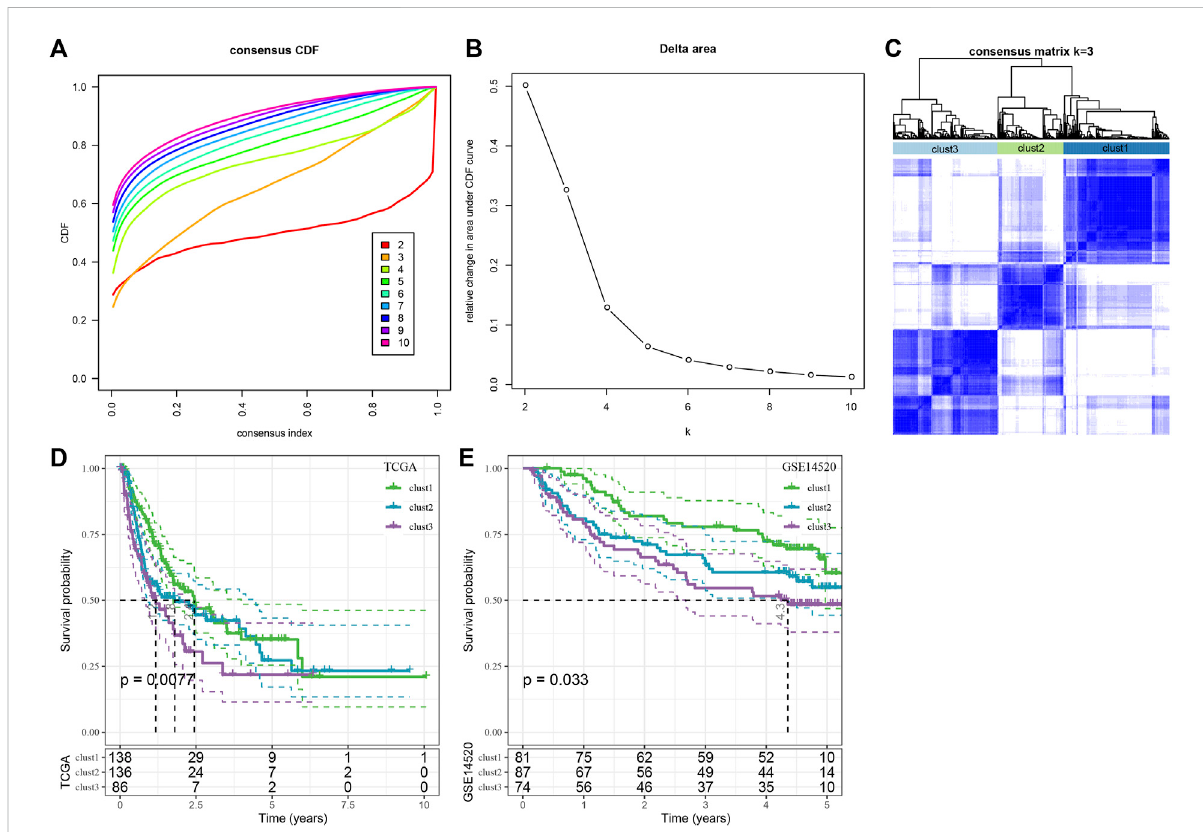
FIGURE 2 Consensus clustering analysis based on the prognosis of cuproptosis-linked genes in liver cancer. (A) CDF curve of TCGA-LIHC dataset samples; (B) CDF-delta area curve for the TCGA-LIHC dataset, Delta area curve for consensus clustering, which indicates the relative difference in the area under the CDF curve for every category number, k, in comparison to the k — 1. The X -axis axis denotes the category number, k, whereas the Y -axis indicates the relative change in the area under the CDF curve; (C) Sample clustering-related heat map when the consumption k = 3; (D) KMcurvesdenotingthecorrelationbetweentheprognosisof3subtypes,identi fi edusingtheTCGA-LIHCdataset; (E) KMcurveofprognosisofthree subtypes in GSE14520